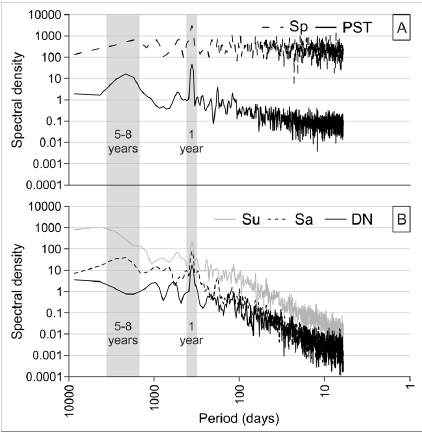
Figure 12. Spectral density functions: rainfall and hydrometry levels ( A ); and piezometric levels ( B ).